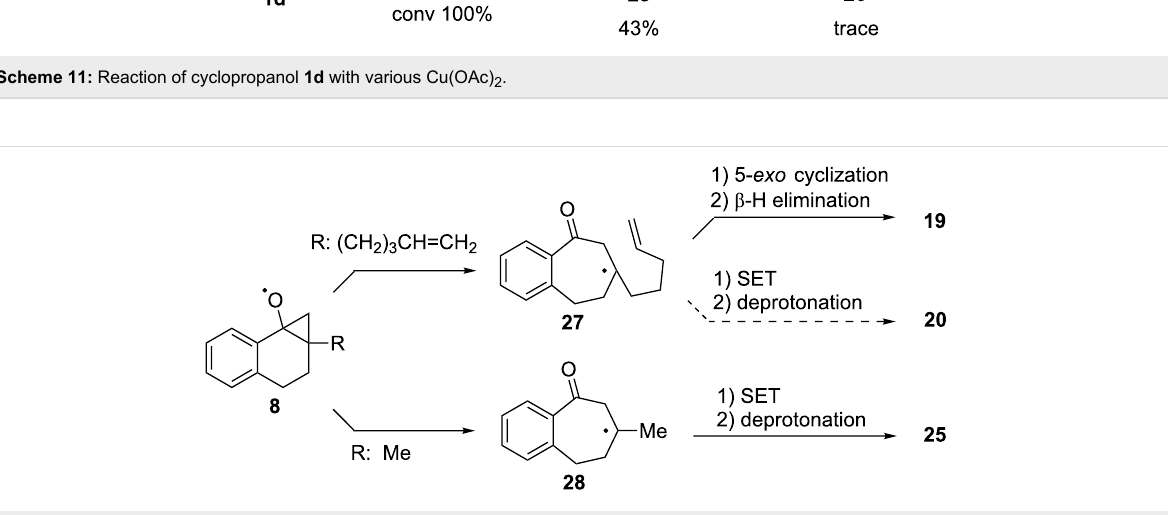
Scheme 12: Comparison of reaction pathways of ring-expanded radical 27 and 28